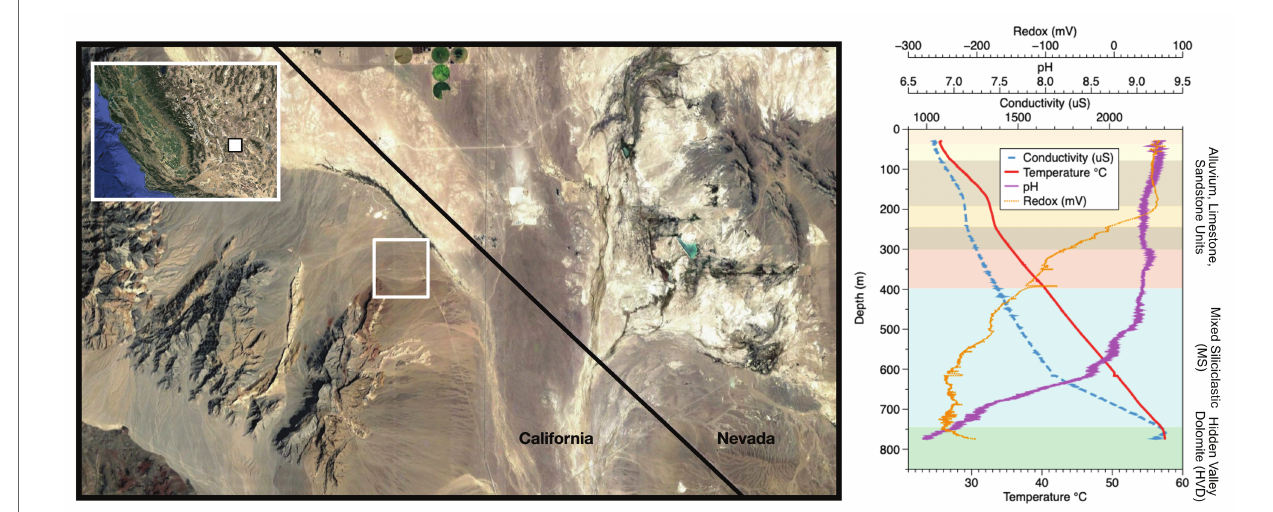
FIGURE 1 | Site location and well profile. (Left) Inyo-BLM 1 is located northeast of Bat Mtn. in the Funeral Mountain Range. Map data: Google, Maxar Technologies. (Right) Geochemical profile of the well overlaid with lithological units as described in Fridrich et al. (2012). The well itself is cased in steel down to 750 m depth, at which point it is open to the Hidden Valley Dolomite (HVD) unit. Geochemical data from the groundwater within the well, which begins at around 28 m depth from surface, are displayed. Although the borehole was originally drilled to 884 m depth, infilling of soft sediments now limits access to approximately 755 m. Map data copyright: attribution of the map data follows Google Earth